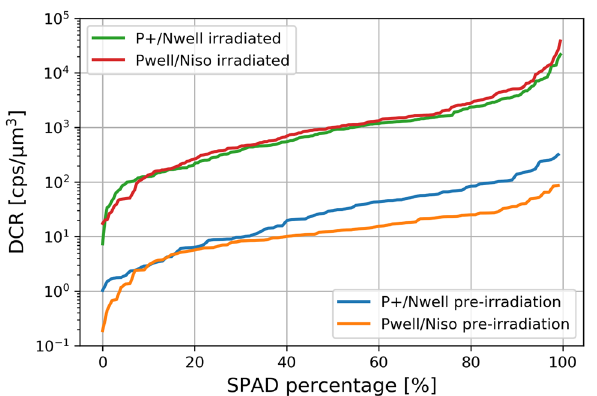
Figure 6. Cumulative distribution of DCR normalized to the active volume for SPADs pre- and post-irradiated with a DDD of 376